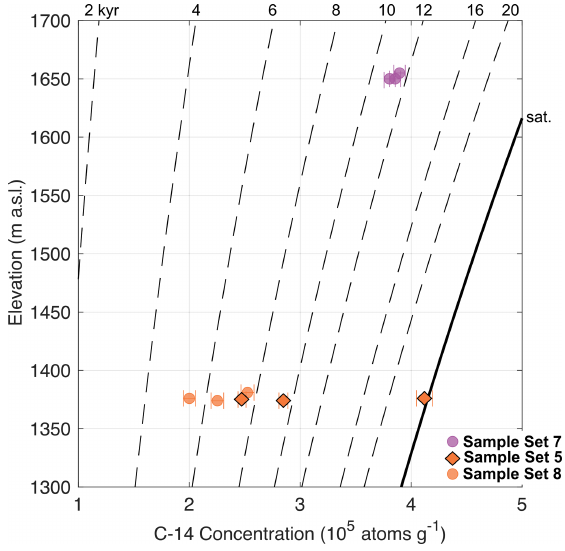
Figure 5. Elevation vs. 14 C concentration. Contours show the equivalent concentrations for a given exposure age as a function of elevation. The heavy black line represents saturation concentra- tion for 14 C. The measurements from the inner moraine (purple) are tightly clustered relative to those of the outer moraines